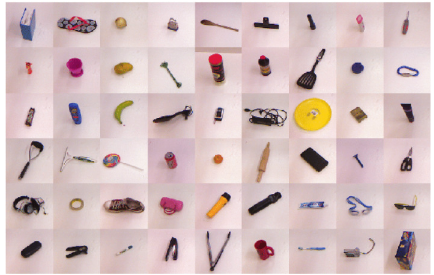
Figure 5: Several objects of Cornell Grasp Dataset. Table 1: Performance of different methods on Cornell Grasp Dataset.